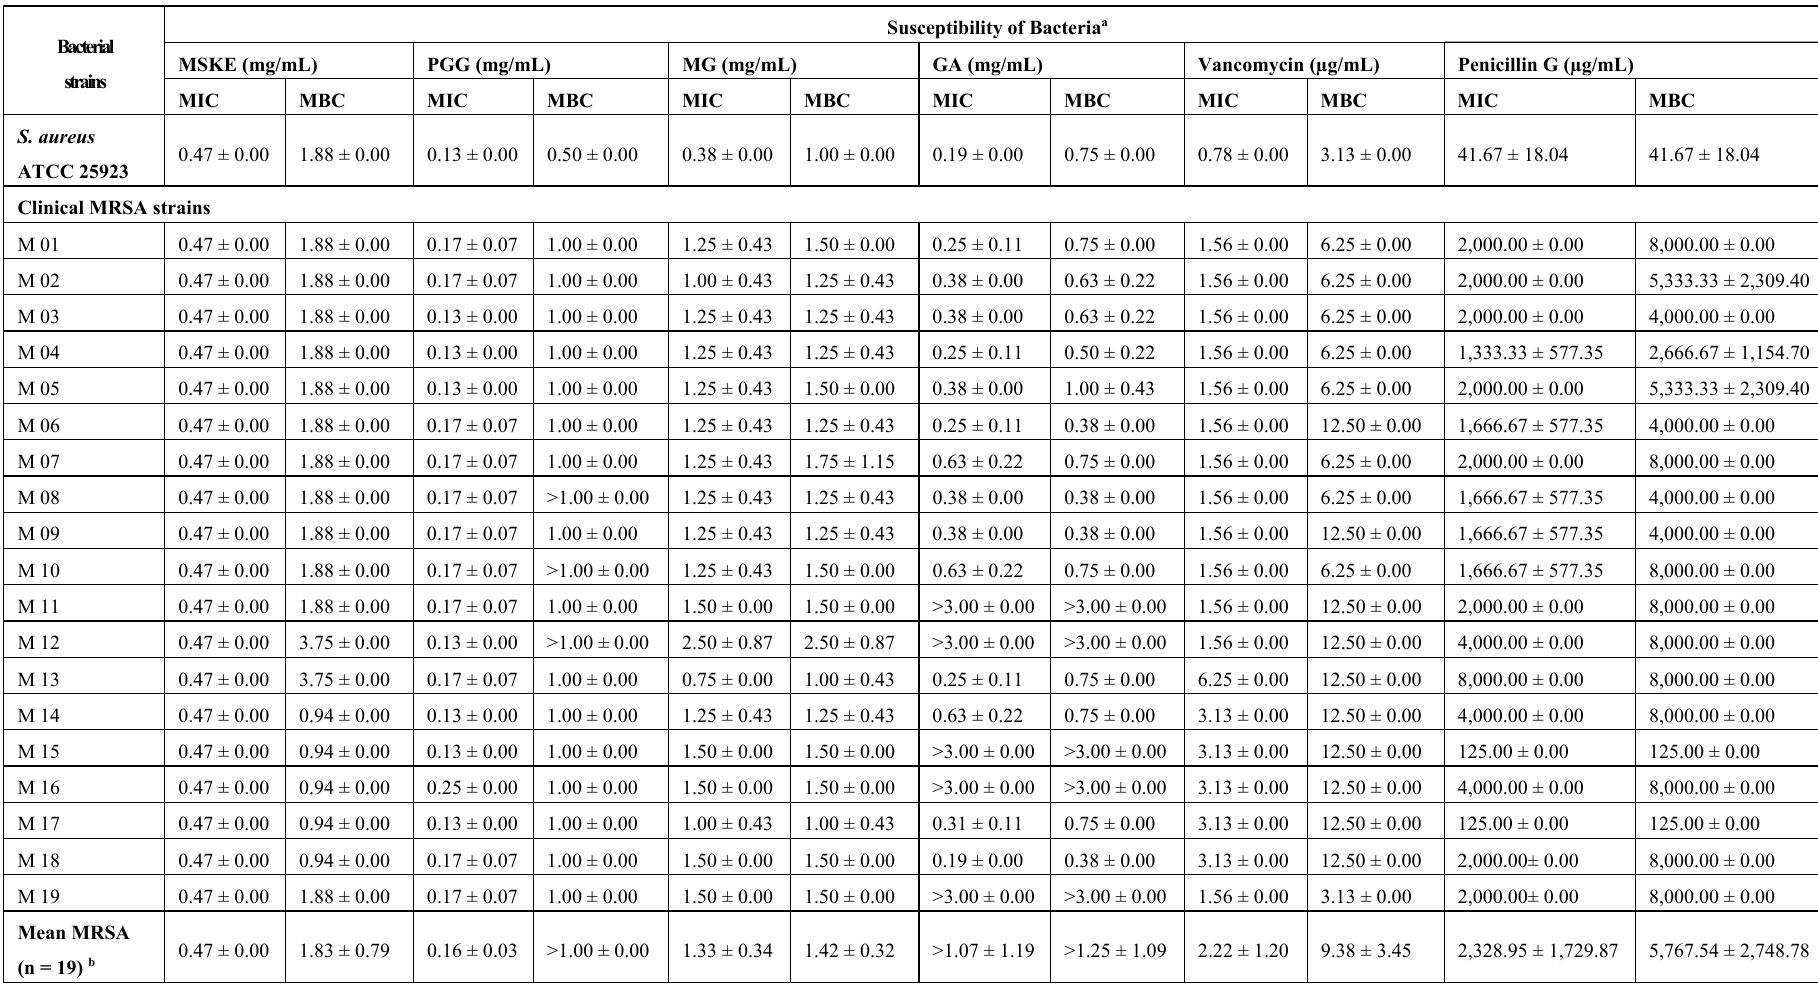
Table 2. The mean MICs and MBCs of MSKE and its phenolic principles against S. aureus ATCC 25923 and 19 clinically isolated MRSA strains ( a mean values ± S.D. of triplicate results, b mean values ± S.D. from 19 MRSA